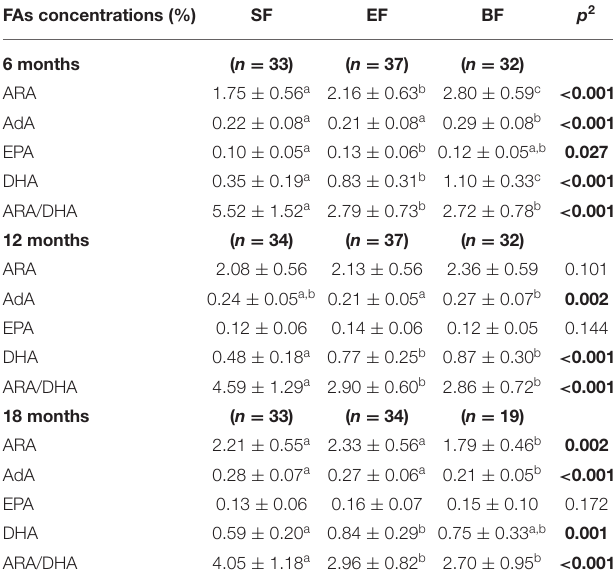
TABLE 4 | Relationship between brain structure and neurocognitive developmental scores in children aged 6 years ( n = 78) a .